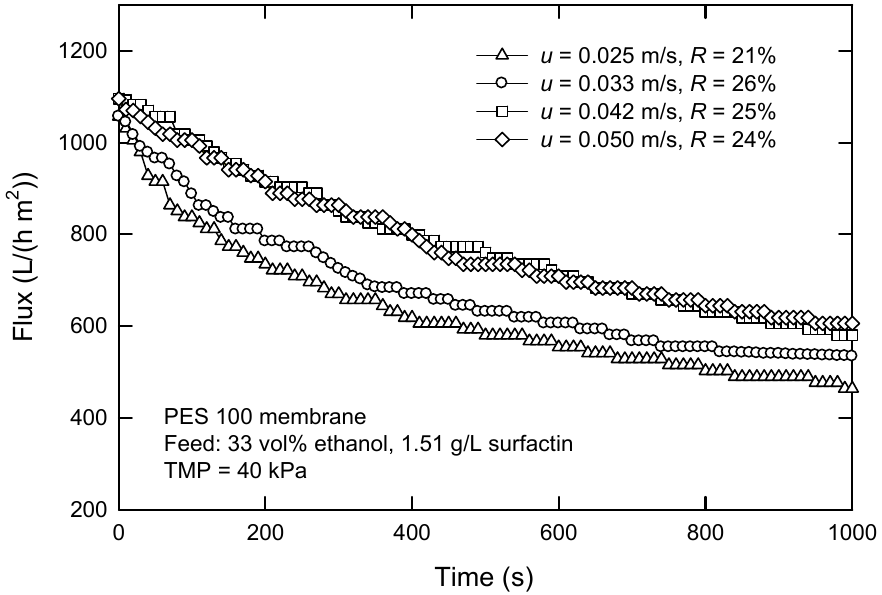
Figure 9. Effect of cross-flow velocity on the flux and surfactin rejection in cross-flow UF using PES 100 membrane.